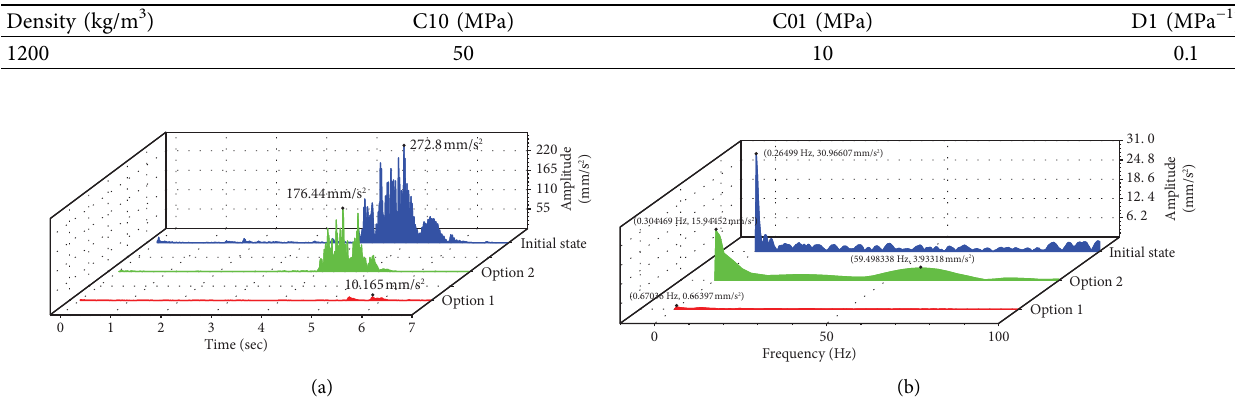
Figure 20: Time-domain and frequency-domain analysis results of the acceleration values at monitoring point B under diferent opti- mization methods. (a) Time domain. (b) Frequency domain.